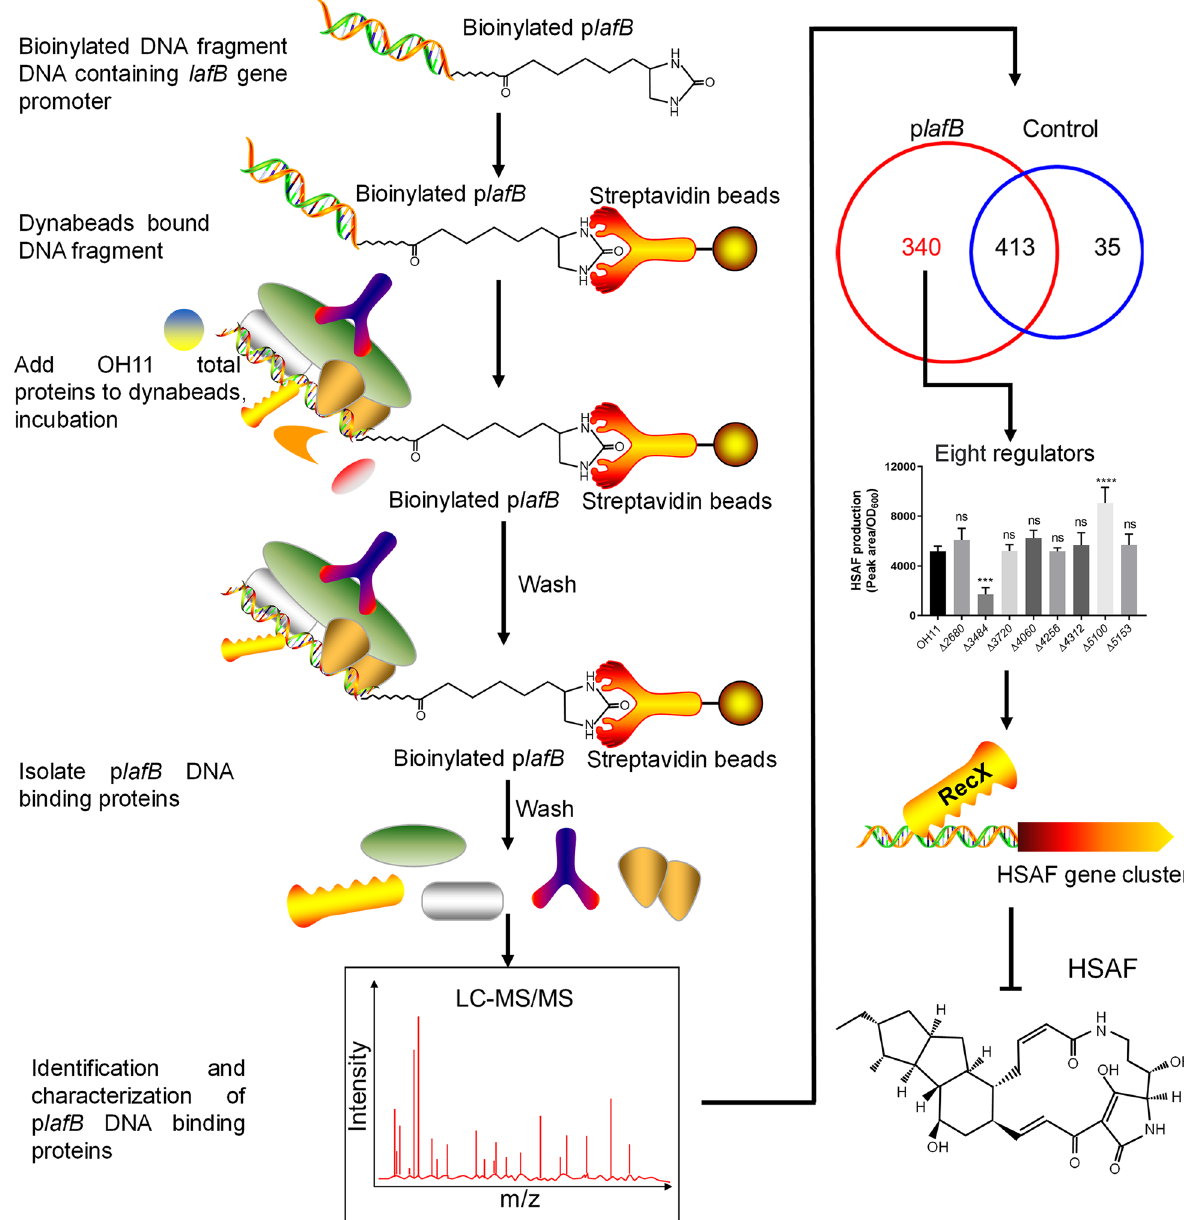
Fig. 7 Model of speculation about RecX regulation mechanism. This study revealed the role of RecX in negatively regulating the production of HSAF in Lysobacter enzymogenes using a DNA pull-down screening